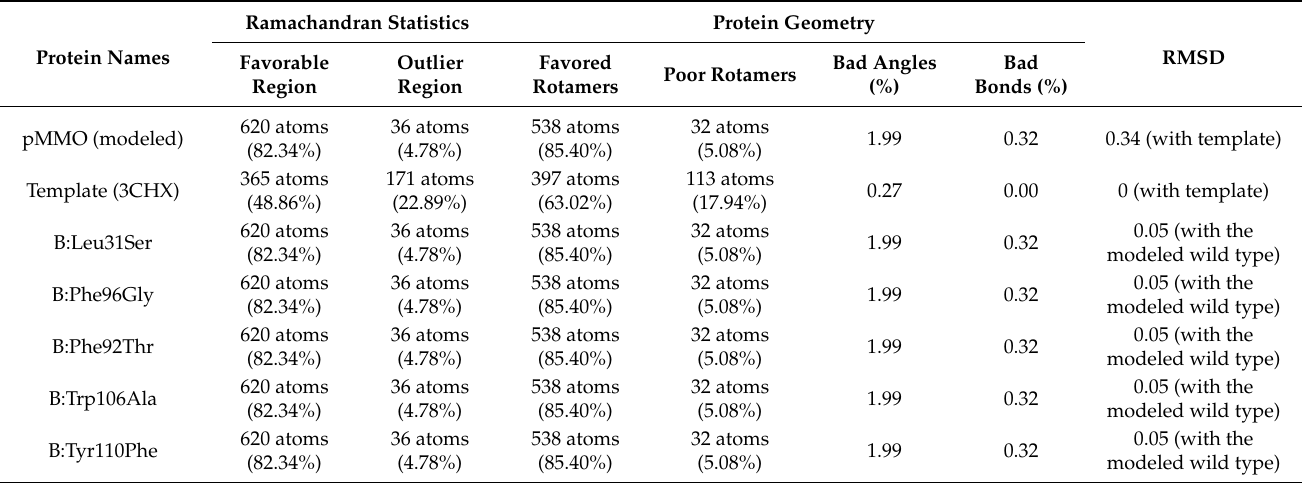
Table 4. Comparison in Ramachandran statistics between the modeled structure and the mutants of